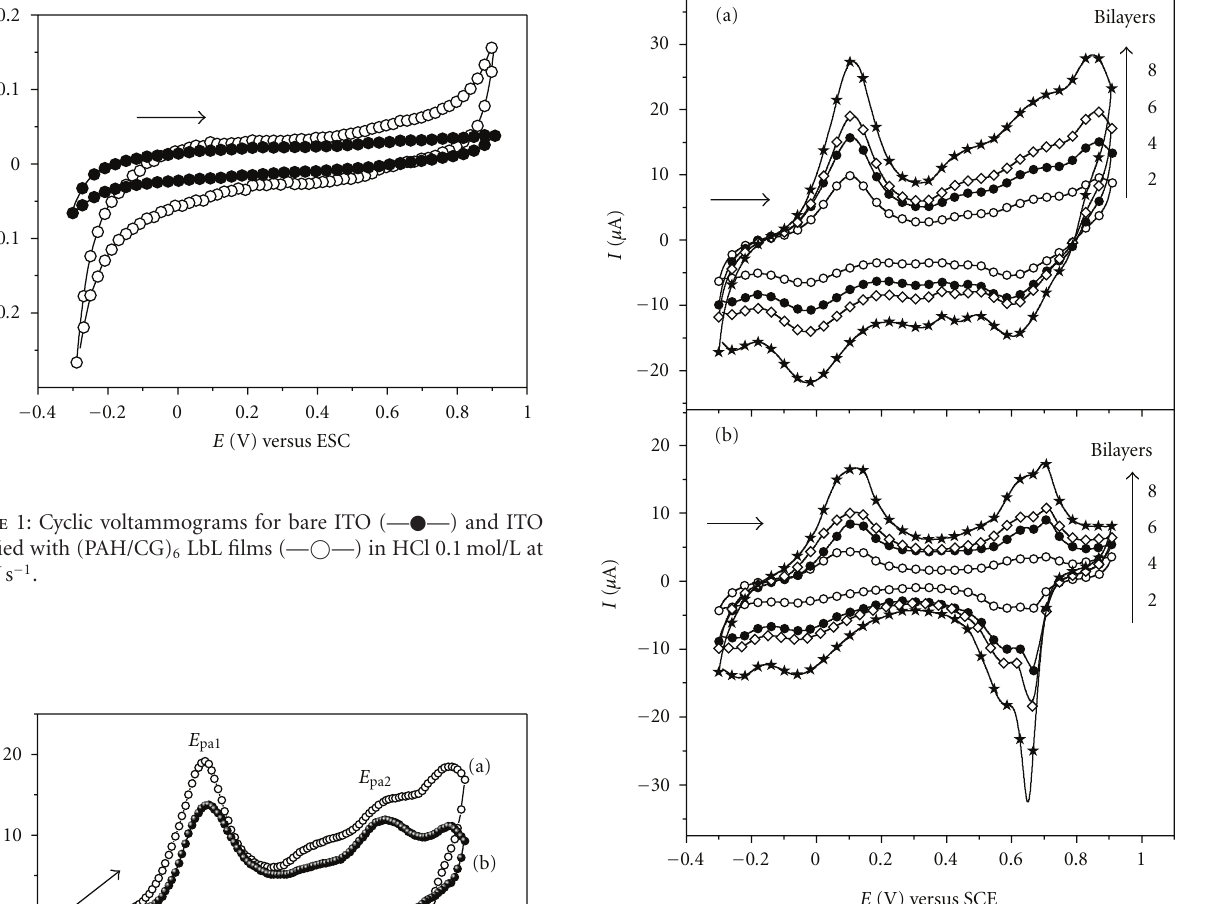
Figure 3: Cyclic voltammograms for LbL films from (a) (PANI- PA/PVS) n and (b) (PANI-PA/CG) n , where n = 2,4,6, and 8 bilayers in 0.1 molL − 1 HCl solution at 50 mVs − 1